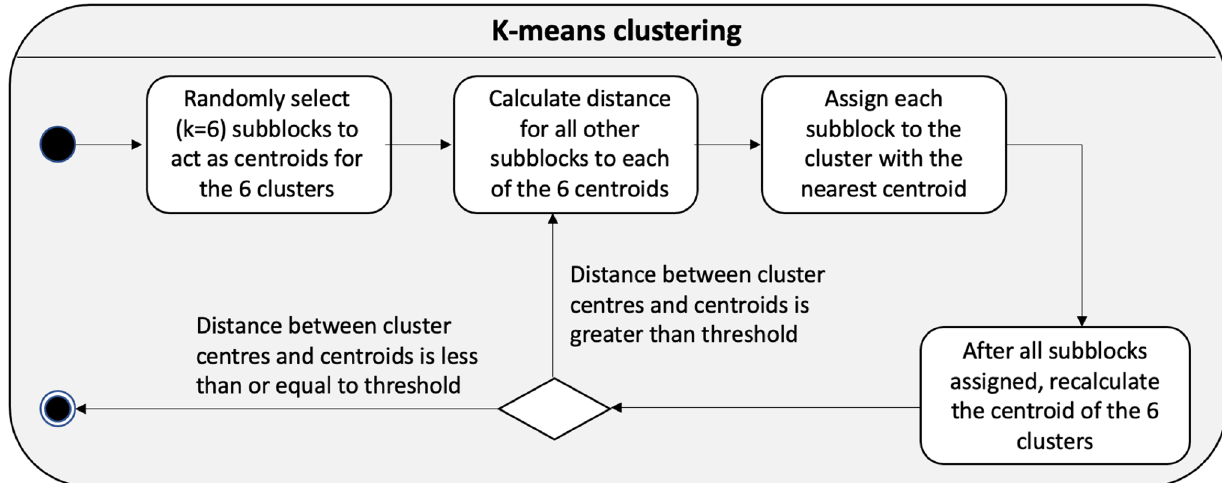
Fig. 7 K-means clustering